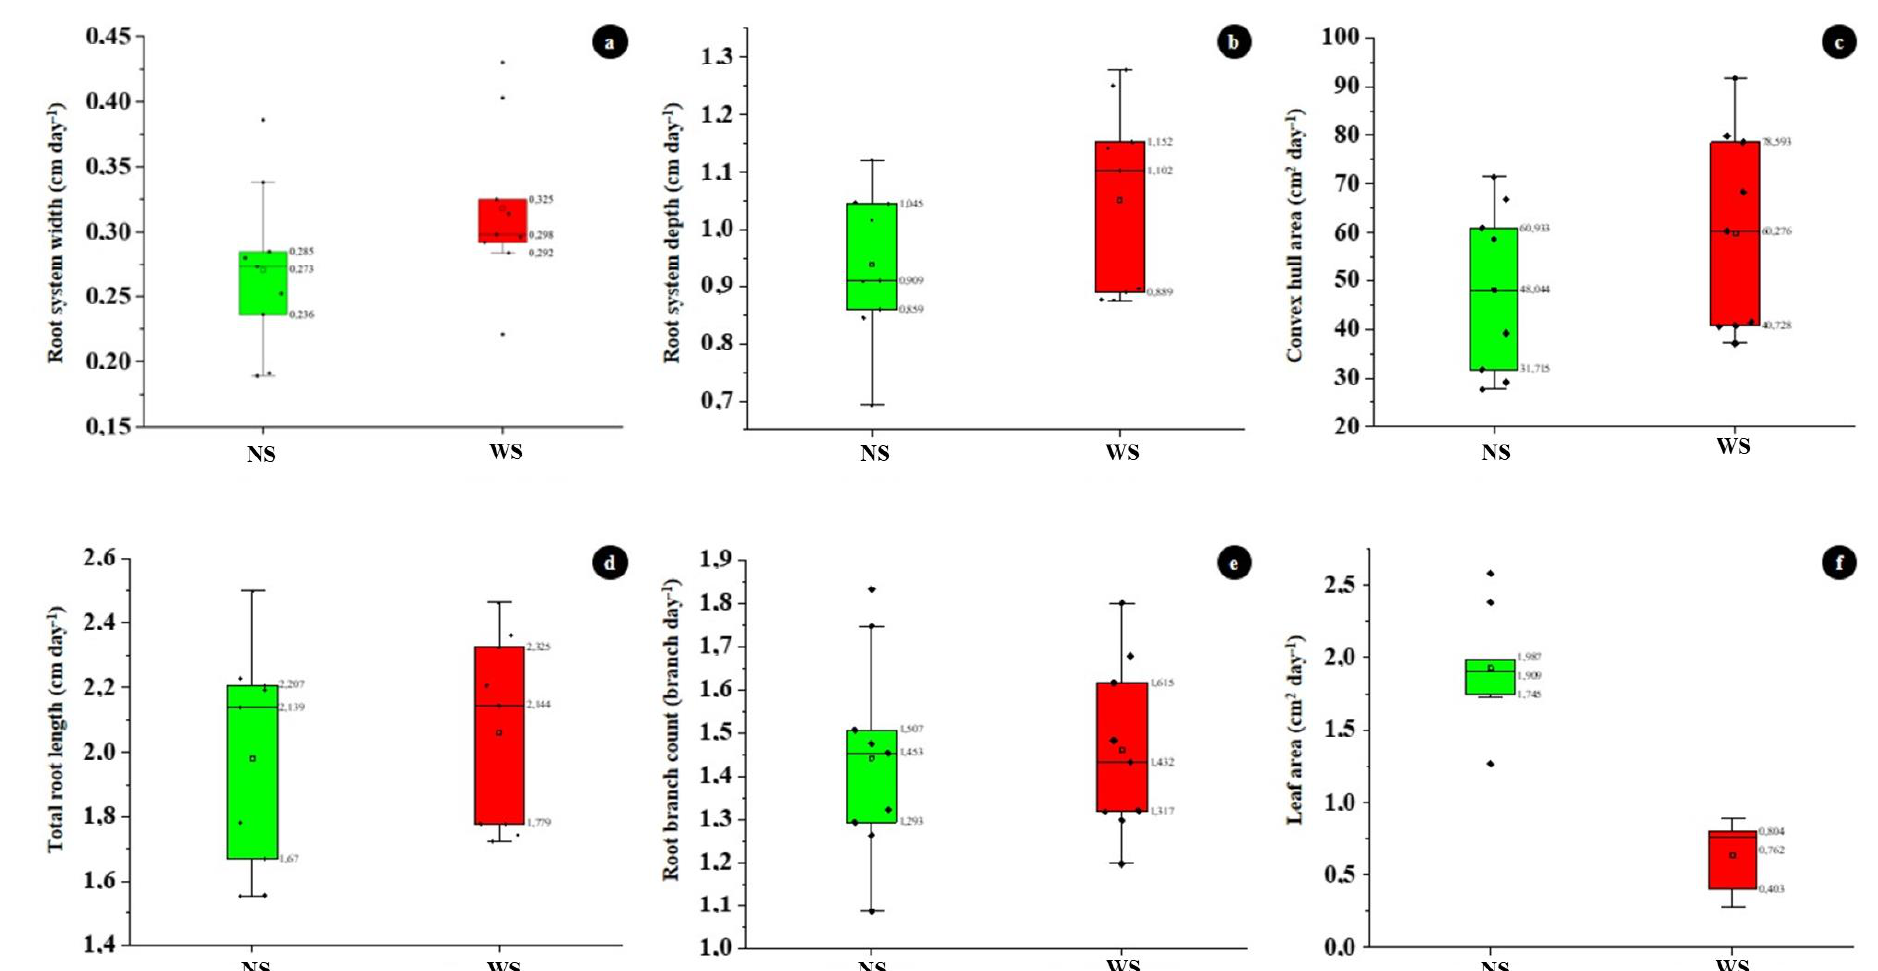
Figure 3. Growth rate comparison of root traits and leaf area under non-stress and water stress conditions ( a ) root system width, ( b ) root system depth, ( c ) convex hull area, ( d ) total root length, ( e ) root branch count and ( f ) leaf area.